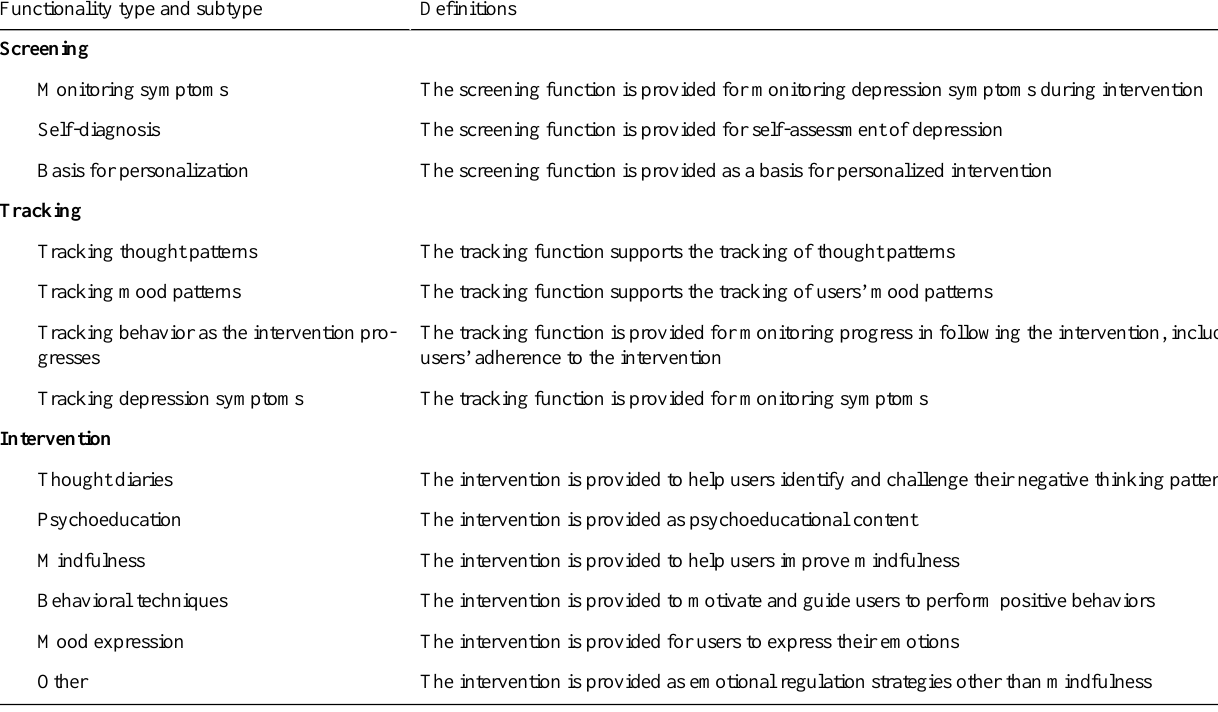
Table 1. Main codes and subcodes from functionality’s